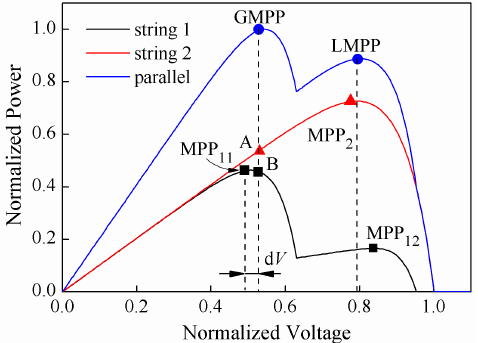
Figure 5. Relationship between the PV array and string MPP.